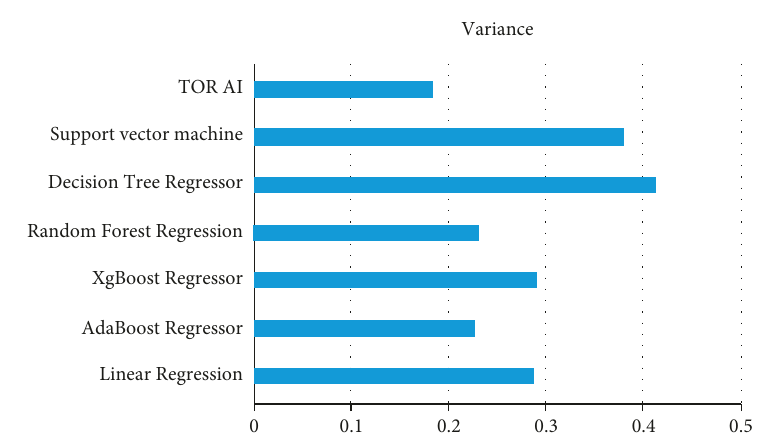
Figure 6: Mean squared report.